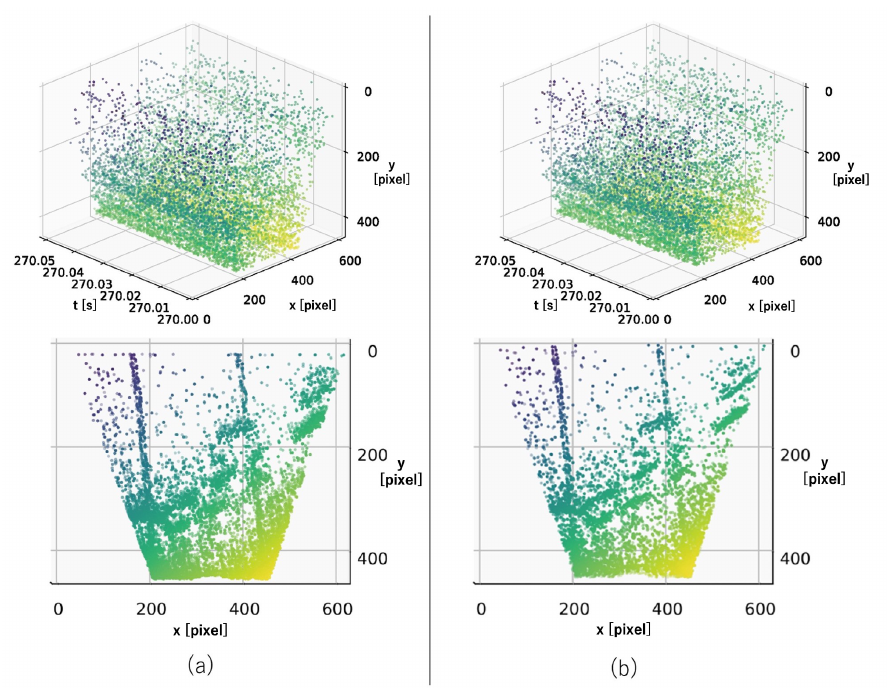
Figure 7. ( a ) Events before the warp. ( b ) Events warped by the isometric motion estimation. The top row shows how the events were warped by the isometric motion estimation in the XYT space. The bottom row shows how they were projected to the IWE.